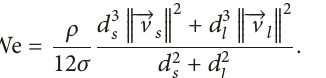
Vessel-1 Vessel-2 Figure 20: Initial gas